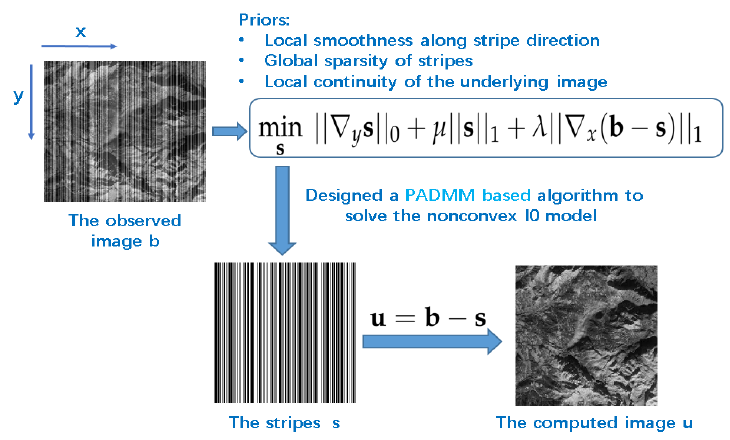
Figure 1. Framework of the proposed destriping